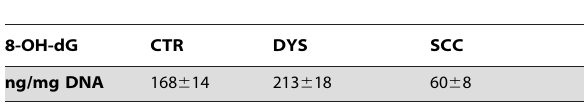
decreased control on cell differentiation maintenance as well as on pro-survival and anti-apoptotic activity of integrated viral oncogenes. Taken together the above data indicate that in dysplastic lesions a selective oxidation of CK6, Actin, Cornulin and RDH, concur to impair their functions contributing to cytoskeleton derangement, suppression of terminal differentiation and reduced control on viral oncogenes activity. Comparative analysis between SCC and CTR tissues did not reveal any significant increase of carbonylated protein. This result is consistent with total protein oxidation levels. However, further larger studies are needed to clarify such an apparent enigma. Comparing the redox proteomics pattern of dysplastic and neoplastic tissues a number of proteins exhibited a lower oxidation in neoplastic tissues namely the ERp57; Anx2; Serpin B3; Pin1 and GAPDH. Table 5. 8-OH-dG levels in control (CTR), dysplastic (DYS) and carcinoma tissues (SCC) are reported as ng of 8-OH-dG/mg DNA.